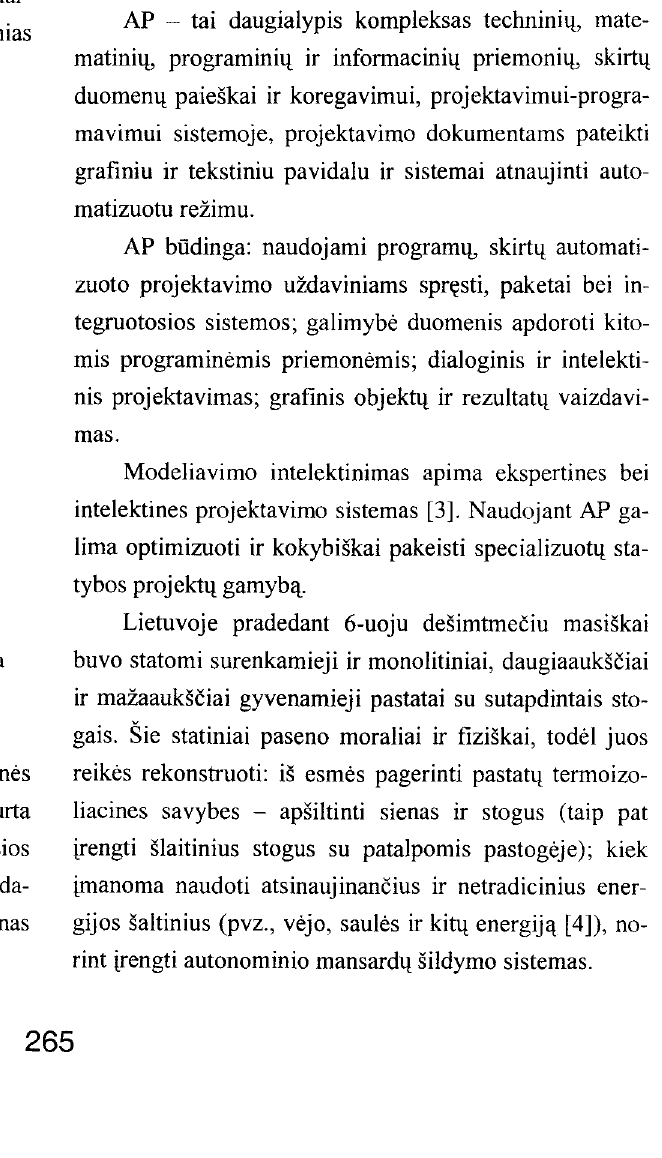
Fig 1. Scheme of intelligence programming Intelektineje sistemoje, skirtingai nuo tradicines kompiuterines sistemos, kuri, be abejo, taip pat sukurta remiantis intelektu, darbo rezultatai priklauso nuo